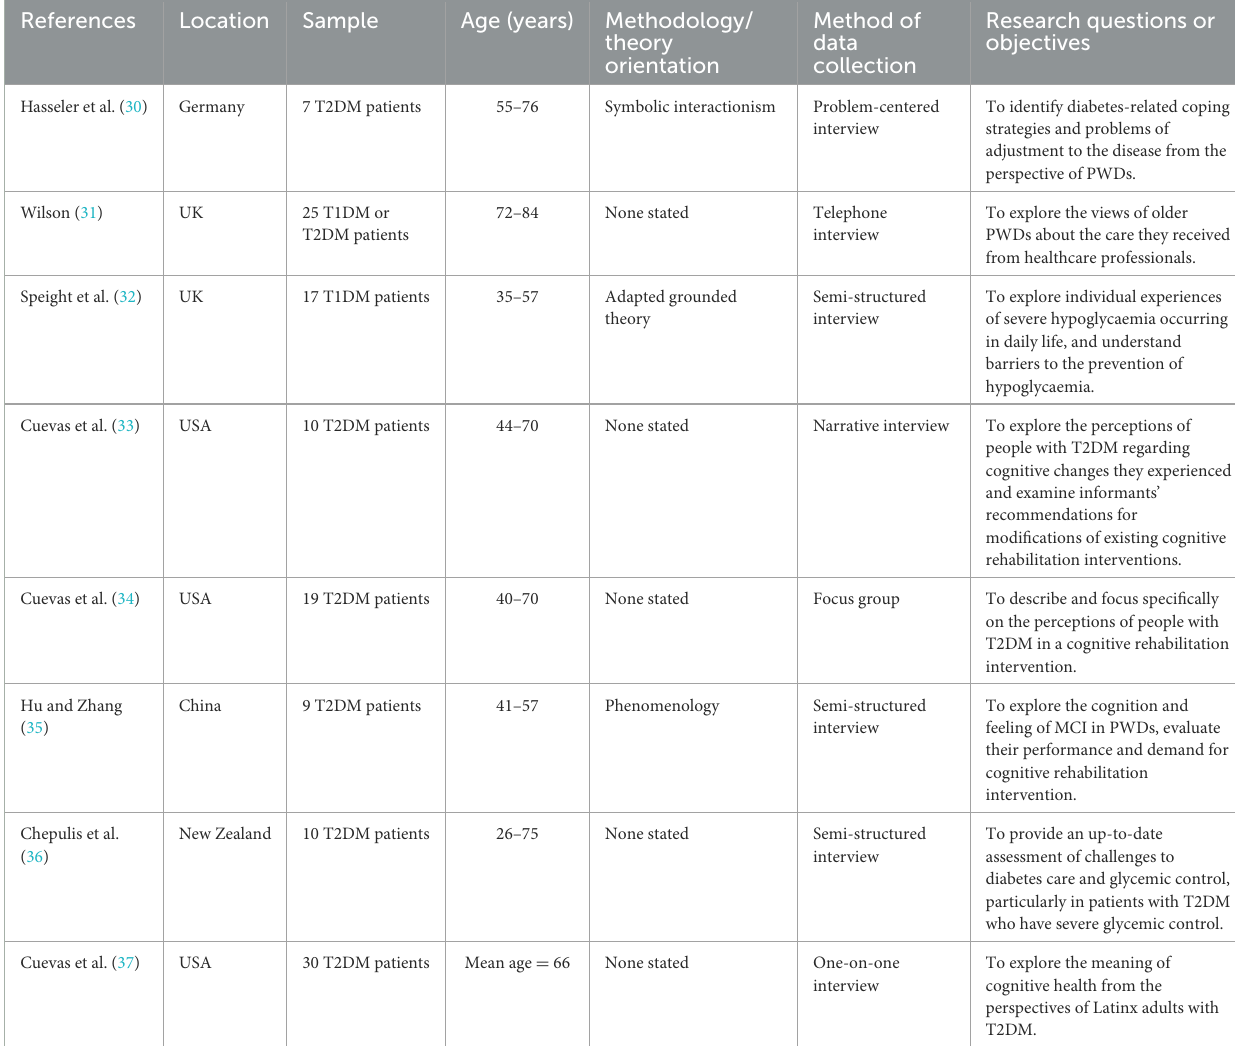
TABLE 1 Characteristics of included